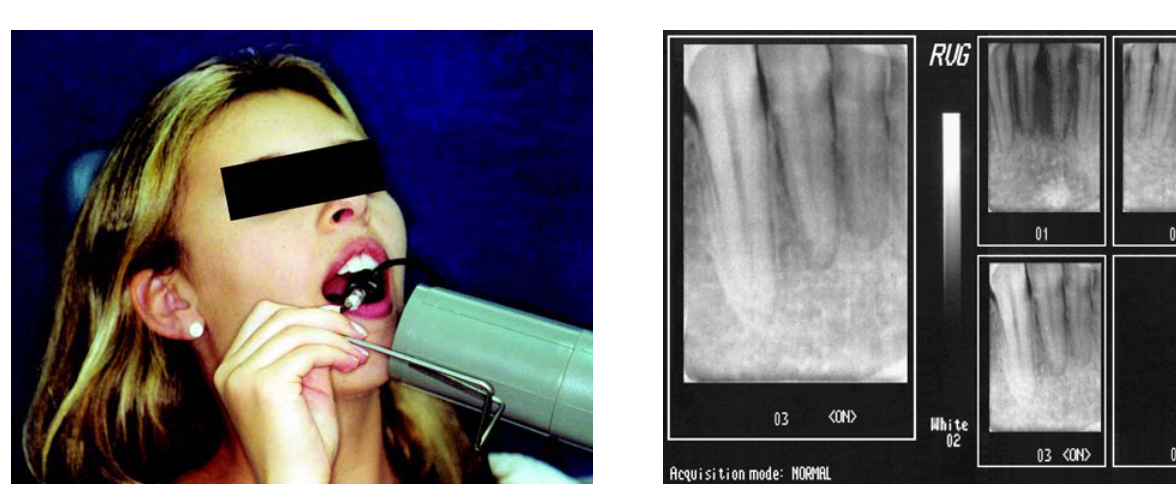
FIGURE 1- Examination (a) and images (b) in vivo with RVG